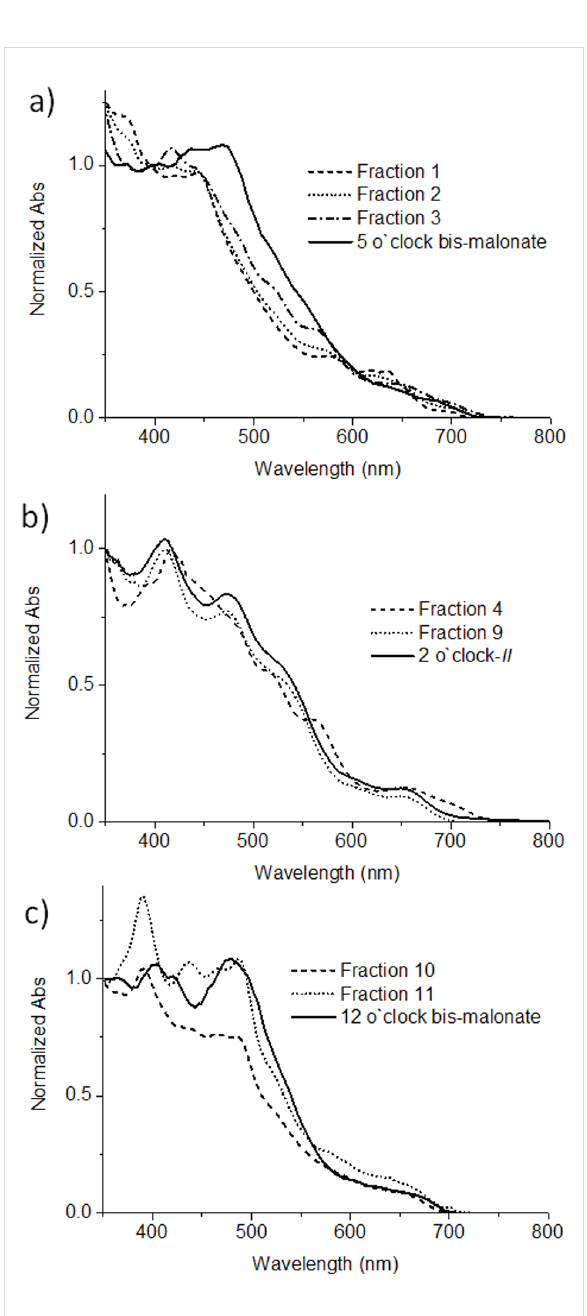
Figure 6: The UV–vis spectrum of each fraction of IC 70 BA as well as known C 70 bisadducts: a) fraction 1, 2, 3 and 5 o`clock bis-malonate [17]; b) fraction 4, 9-1 and 2 o`clock-B of IC 70 BA [9]; c) fraction 10, 11 and 12 o`clock bis-malonate [17].